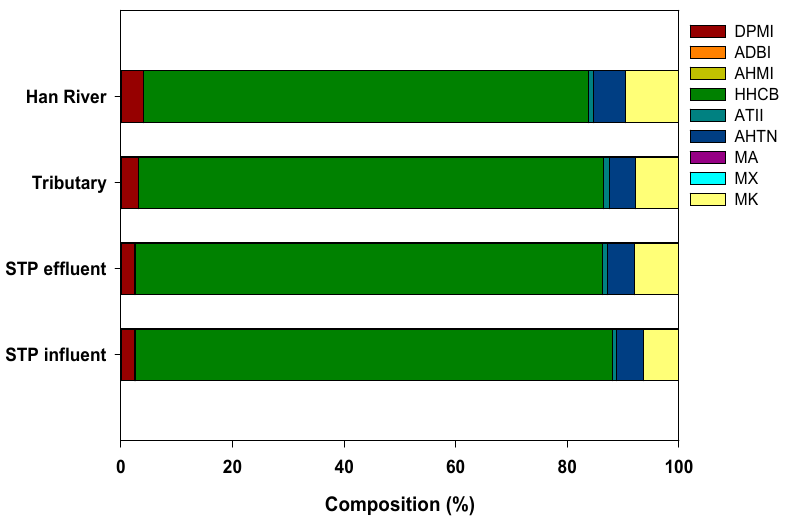
Figure 2. Compositions of synthetic musk fragrances in the STP influent, effluent, tributary, and the Han River.